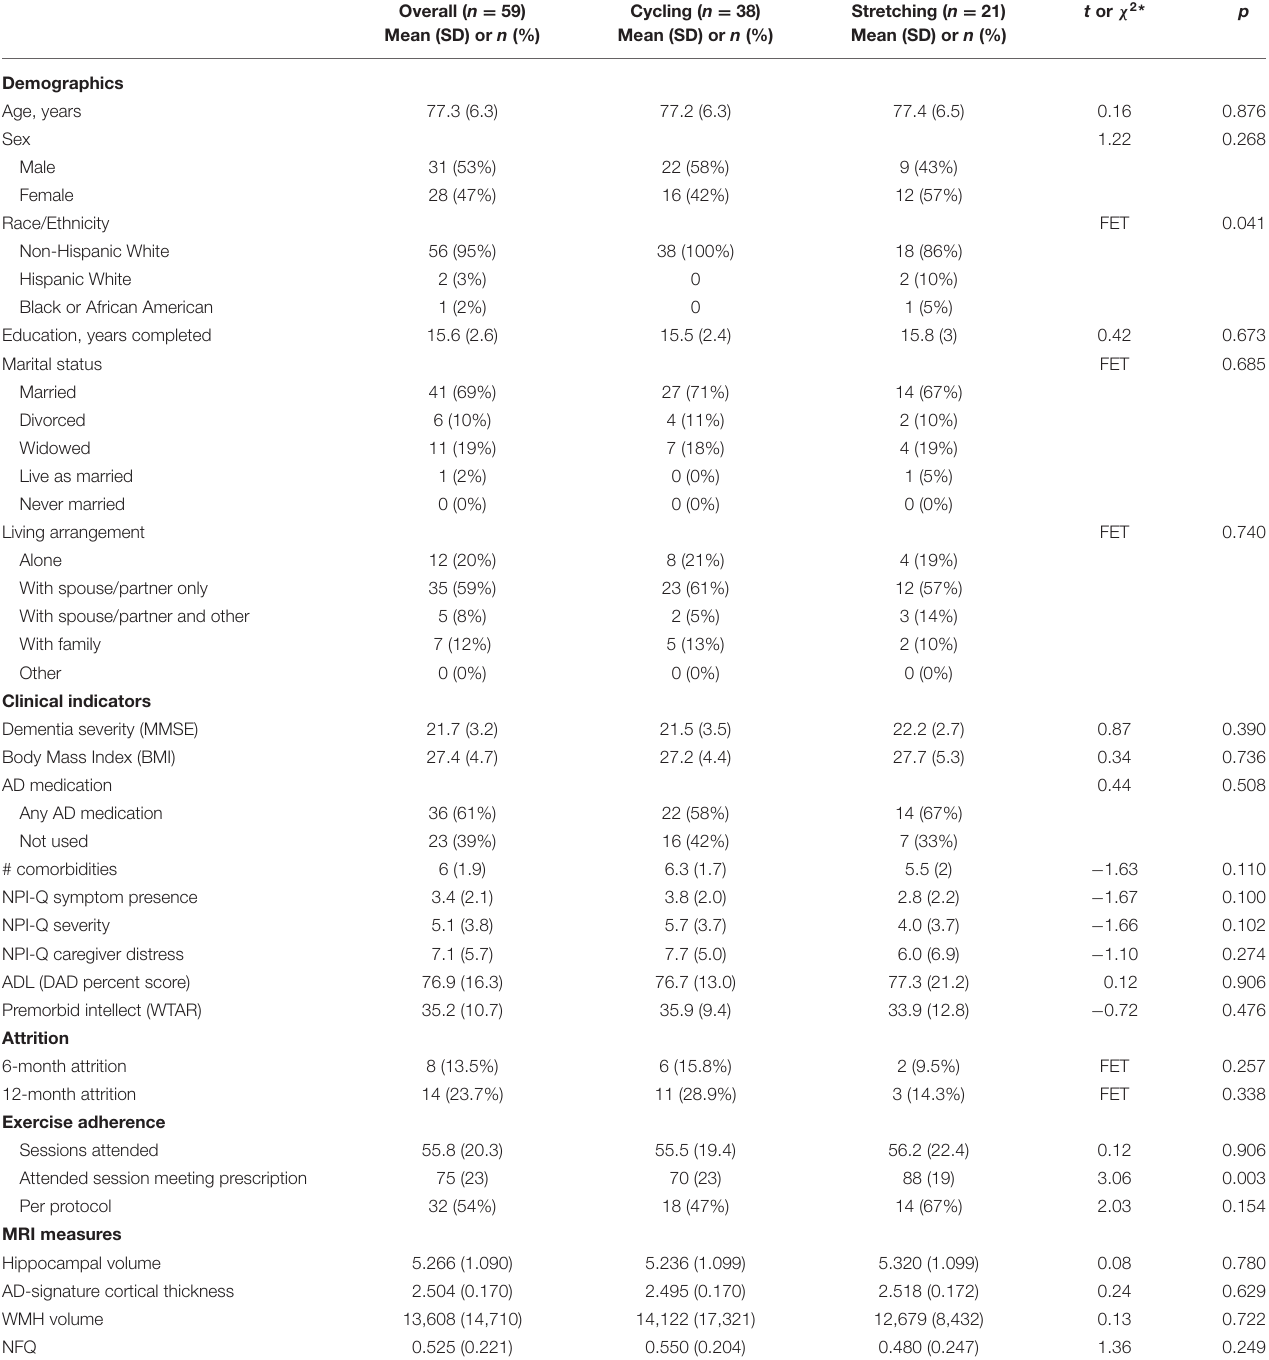
TABLE 1 | Characteristics of the study MRI sample at baseline ( n =